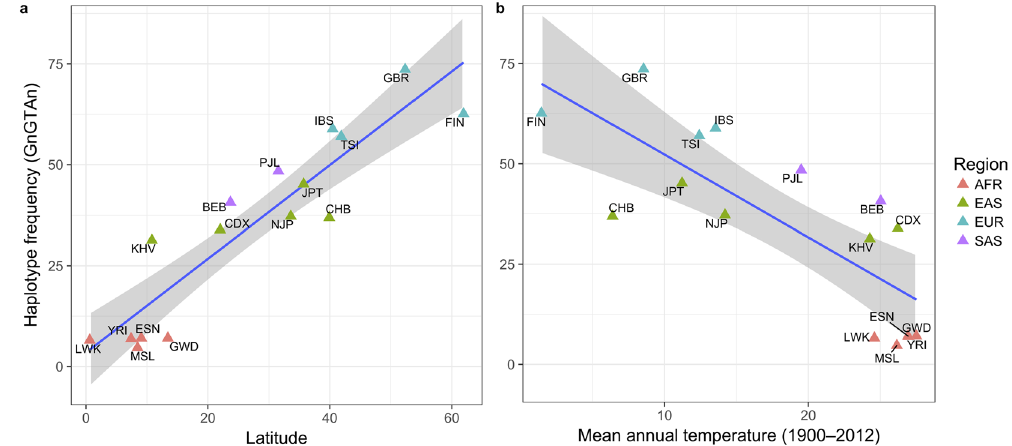
Figure 2. Correlation between the haplotype showing the highest efficiency thermogenesis and the latitudes ( a ) and mean annual temperatures ( b ) of global human populations deposited in the 1000 Genomes Project database. Blue line and grey band represent a regression line and its 95% confidence interval. Each color of triangle indicates the geographical region of populations. Dashed line represents a regression line, and orange triangle indicates the frequency and latitude of our subjects. The abbreviations used are the following: African (AFR): ESN (Esan in Nigeria), GWD (Gambian in Western Divisions in the Gambia), LWK (Luhya in